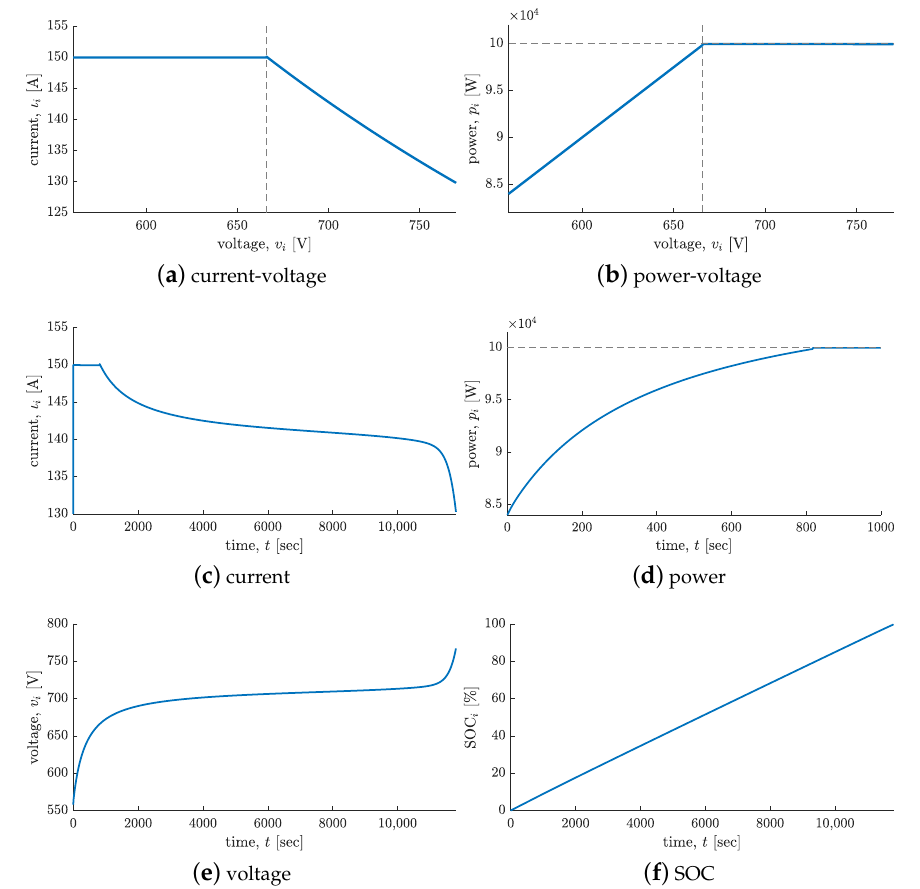
Figure 2. Characteristic curves of the batteries. ( a ) Current–voltage curve. ( b ) Power–voltage curve. ( c ) Current ι i over time. ( d ) Power p i over time. ( e ) Voltage v i over time. ( f ) SOC over